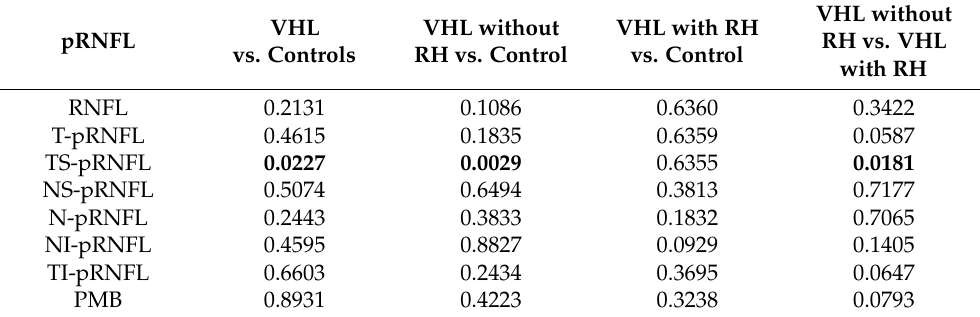
Table 3. Statistical significance ( p -value) of pRNFL thickness in the analyzed